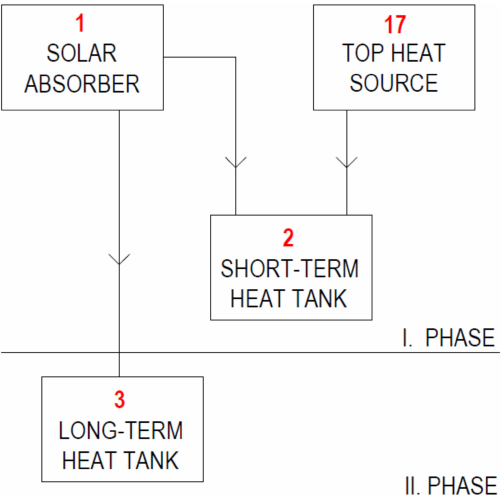
Figure 7. Functional diagram of the solar thermal energy storage operation [17].